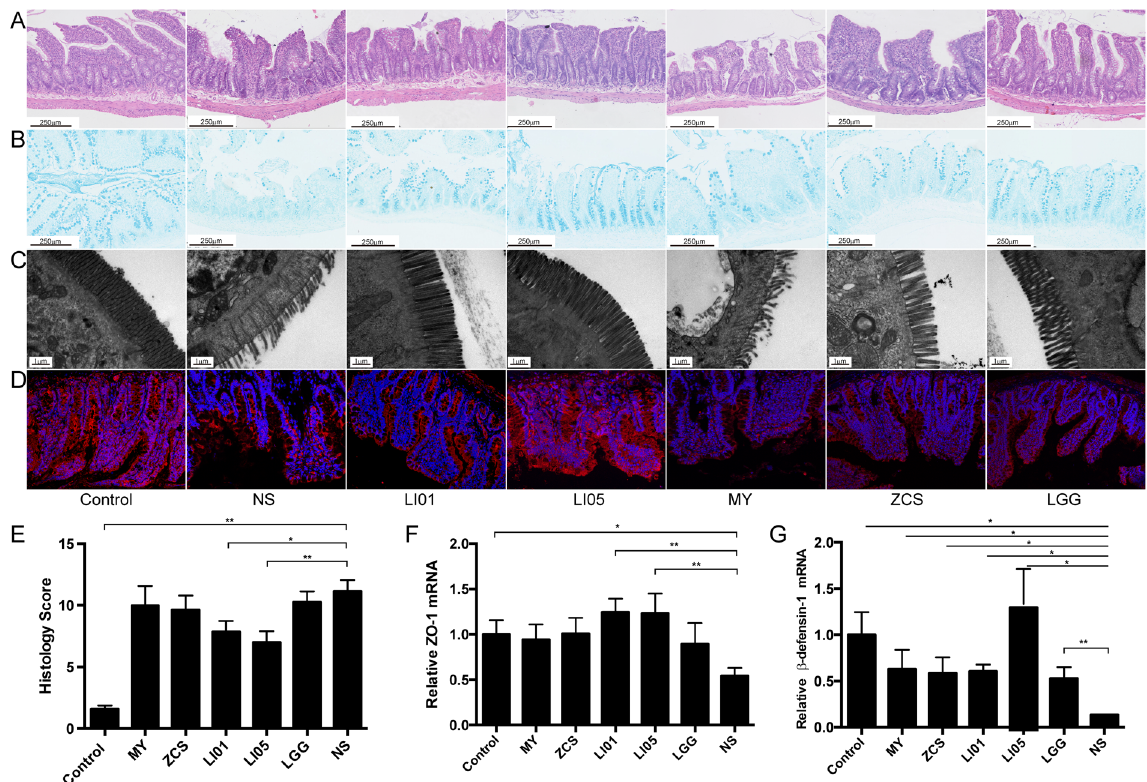
Figure 3. Treatment with L. salivarius LI01 or P. pentosaceus LI05 improved intestinal barrier function in cirrhotic rats. ( A – D ) Representative images of histological alternations in the ileum assessed by ( A ) H&E staining, ( B ) Alcian blue staining, ( C ) the ileal mucosal ultrastructure, and ( D ) ileal ZO-1 immunofluorescence ( × 20) from the Control, NS, LI01, LI05, MY, ZCS, and LGG groups. The scale bar in panel 1 is 250 μ m and in panel 2 is 1 μ m. ( E ) Ileum inflammation was monitored based on the histology scores following the criteria presented in the Materials and Methods. ( F , G ) Ileal ZO-1 and antimicrobial peptide β -defensin-1 gene expression were determined by quantitative PCR. All data are given as the mean ± SEM. * P < 0.05 and ** P < 0.01 vs. normal saline-treated cirrhotic rats in the NS